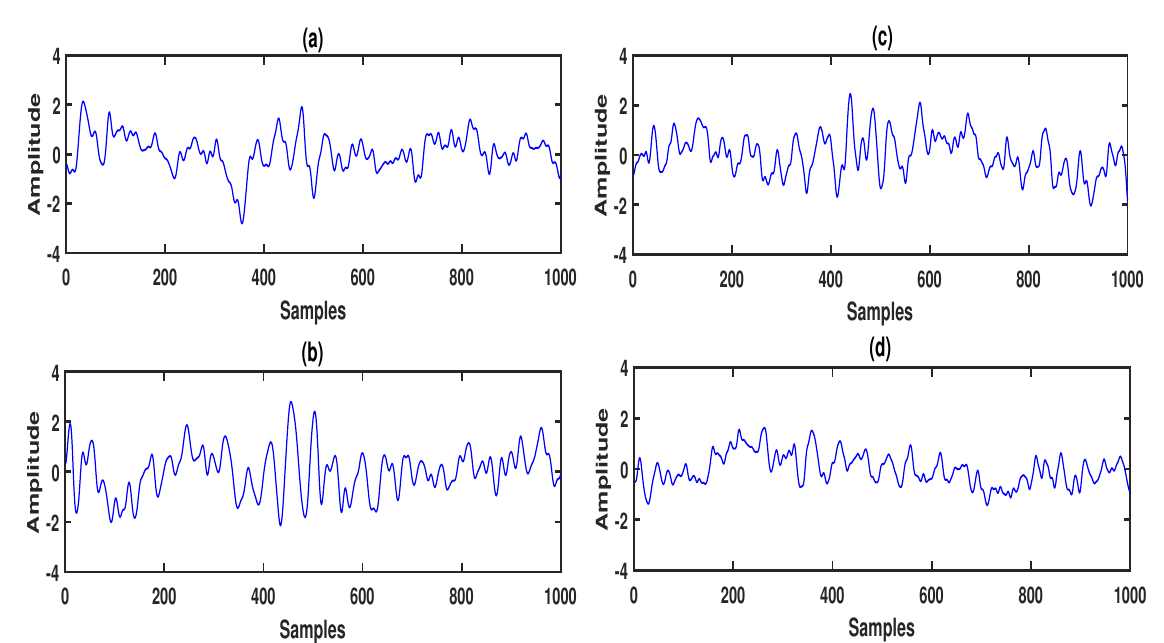
Figure 3. ( a ) Fp1 channel EEG signal corresponding to a BMAC task. ( b ) O1 channel EEG signal corresponding to a BMAC task. ( c ) Fp1 channel EEG signal corresponding to a GMAC task. ( d ) O1 channel EEG signal corresponding to a GMAC task.